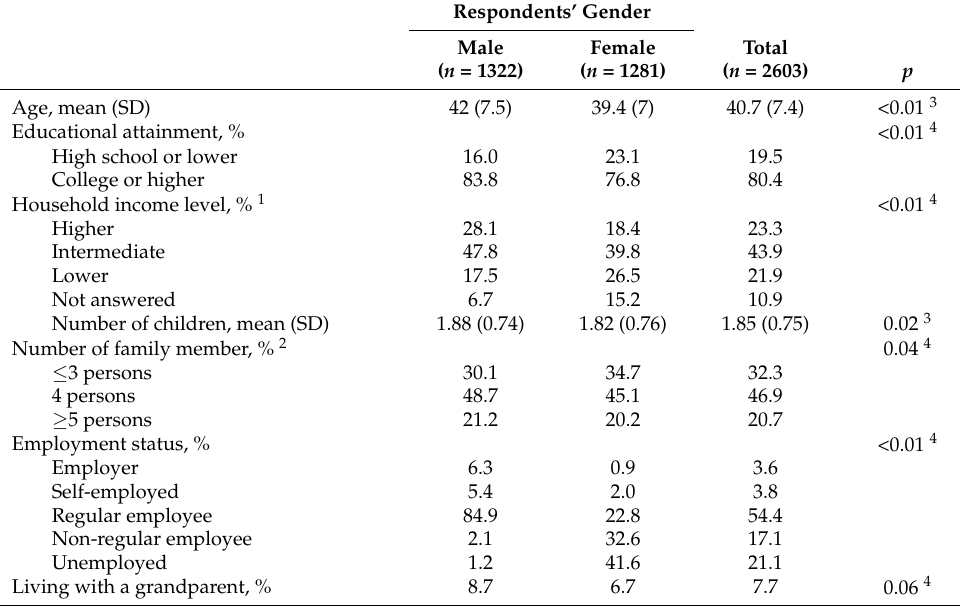
Table A2. Characteristics by gender among two-parent households.